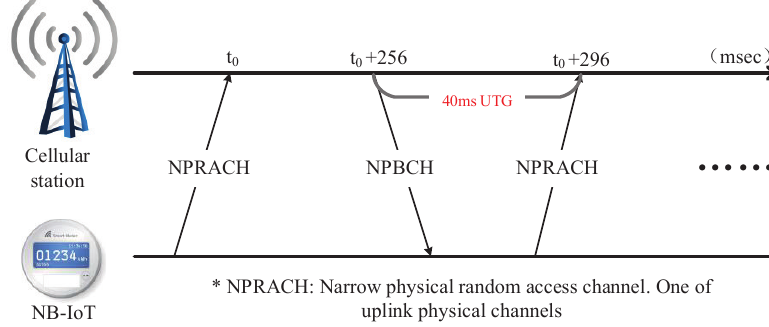
Figure 3. Illustration of the UTG inserted during the uplink transmission of